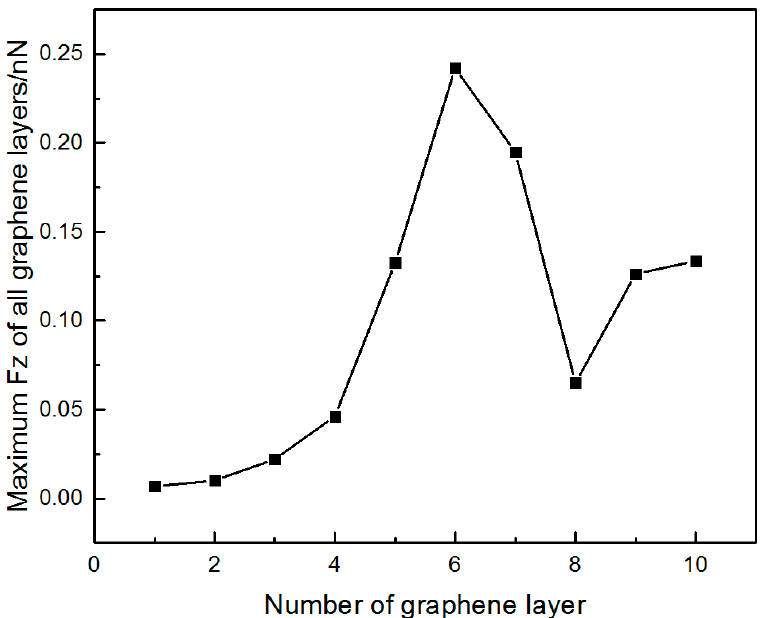
Figure 14. The maximum Fz to exfoliate all layers.